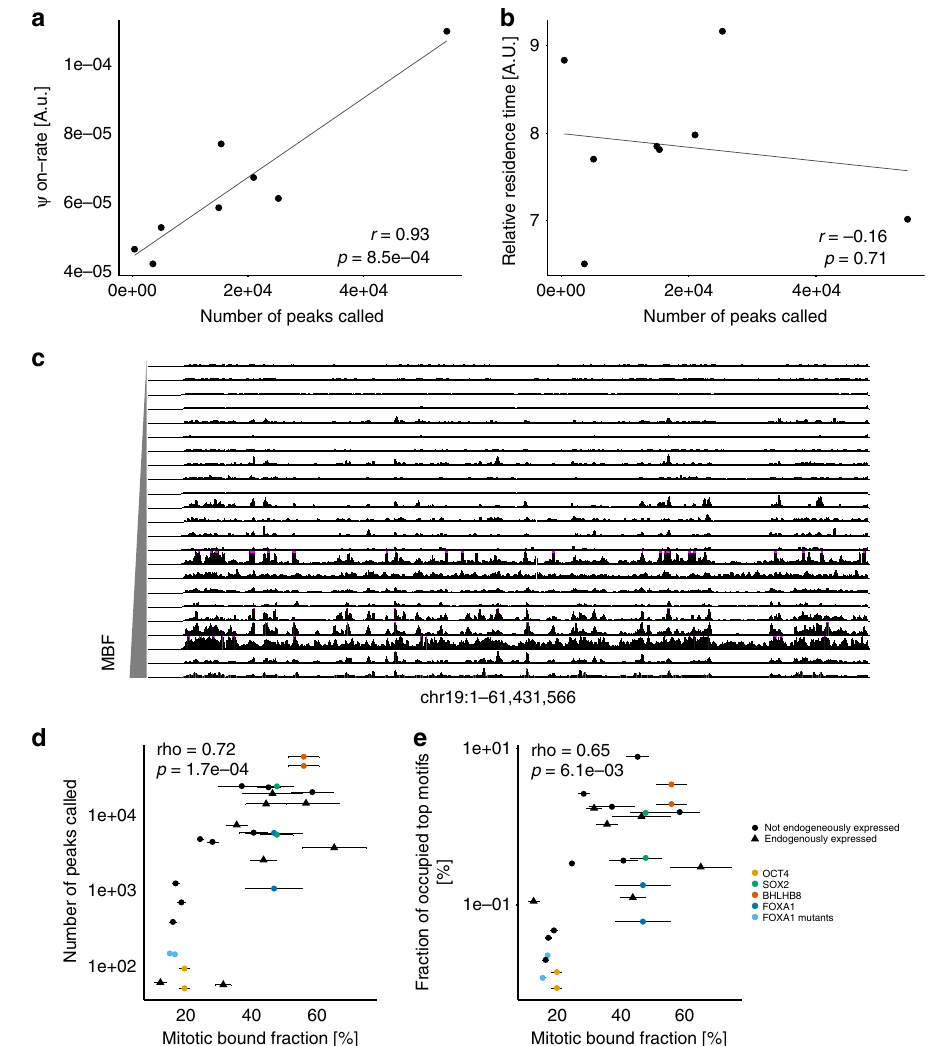
Fig. 4 Mitotic chromosome binding predicts genome-wide TF occupancy. a Correlation between the number of ChIP-seq peaks called and the ψ on-rate for 8 different TFs. r -value (r) and p -value ( p ) are based on Pearson correlation. b Correlation between the number of ChIP-seq peaks called and TF relative residence times for 8 different TFs. r -value ( r ) and p -value ( p ) are based on Pearson correlation. c Genome tracks of RPKM-normalized bigWig fi les for each TF. The region encompasses the entire chromosome 19. The y -axis is scaled equally for all factors. d Correlation between the mitotic bound fraction and the number of ChIP-seq peaks called. Duplicates are indicated for OCT4 (yellow), SOX2 (green), BHLHB8 (red), and FOXA1 (dark blue). The two FOXA1 mutants are shown in light blue. Triangles TFs endogenously expressed in NIH-3T3. Circles: TFs not endogenously expressed in NIH-3T3. Rho- value (Rho) and p -value ( p ) are based on Spearman ’ s rank correlation. e Correlation between the mitotic bound fraction and the number of ChIP-seq peaks displaying the most frequently found motif for each TF, normalized over the total number of motif occurrences in the genome. Same color and shape coding as d . Rho-value (Rho) and p -value ( p ) are based on Spearman ’ s rank correlation. Error bars: